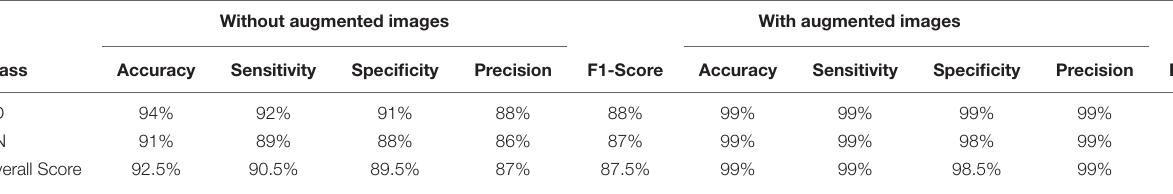
TABLE 4 | Overall accuracy of DenseNet 121 for PD and control subject.